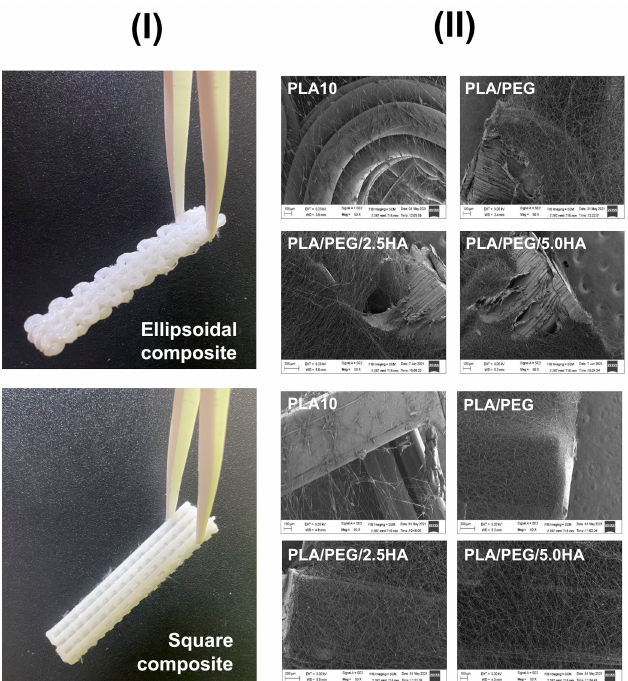
Figure 6. ( I ) Images of 3D-printed/electrospun composites obtained after combining 3D-printed PLA pieces with ellipsoidal and square pores with PLA-based fibers. ( II ) SEM images of the fibrous layer of PLA-based electrospun composites deposited over the surface of 3D-printed pieces.